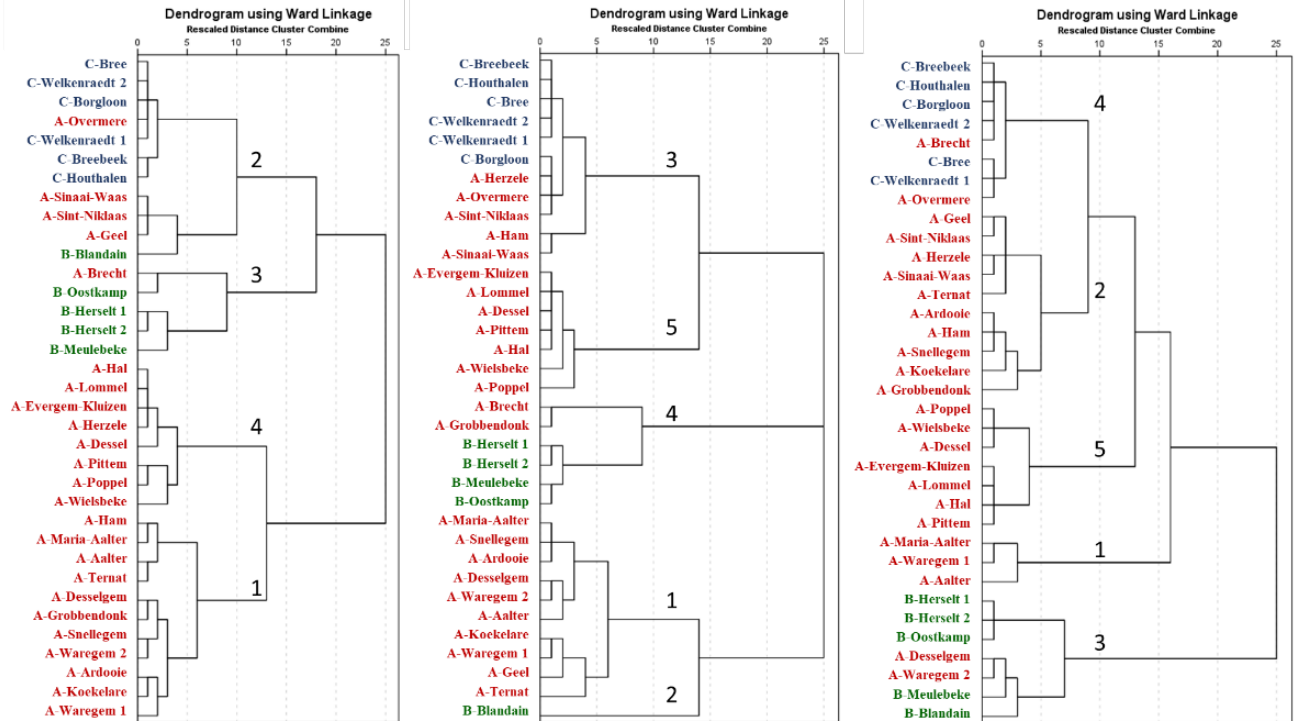
Figure 5. Three dendrograms (one for each experimental year, from left to right: 2018, 2019, and 2020) of 35 C. esculentus clonal populations clustered by Ward’s method based on morphological traits. Clonal population origin is preceded by a capital letter indicating to which genetic cluster (A, B, or C, see Figure 3) the clonal population is assigned to. Four morphological clusters were retained for 2018 and five for 2019 and 2020.